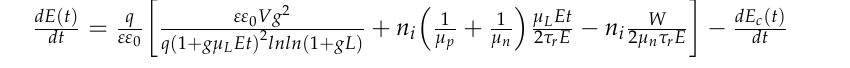
Figure 8. The flux density of lithium-ions in a crystal during the double-sided drift process, taking into account the presence of uncompensated lithium-ions.